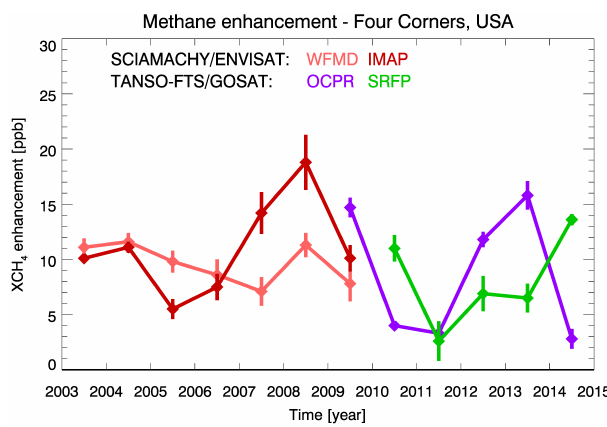
Figure 15. Methane enhancements over the Four Corners area for all years and all four satellite data products used in this study. The error bars show the standard deviation of the methane enhancements obtained by varying the size and shape of the surrounding area.